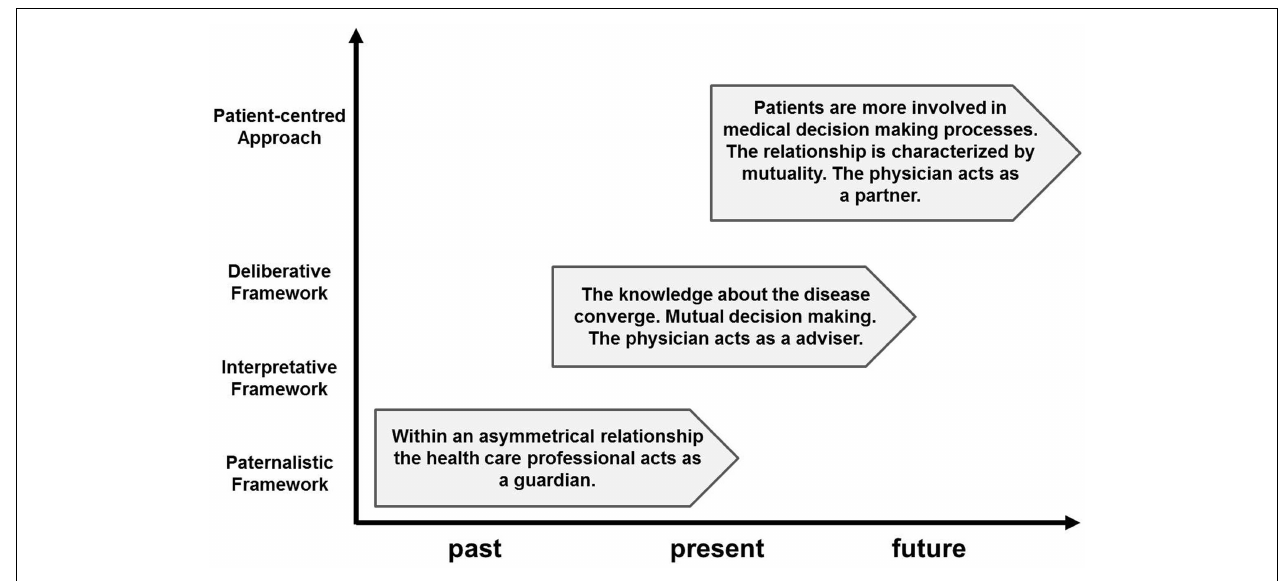
FIGURE 1 | Overview of conceptual frameworks for patient-professional communication